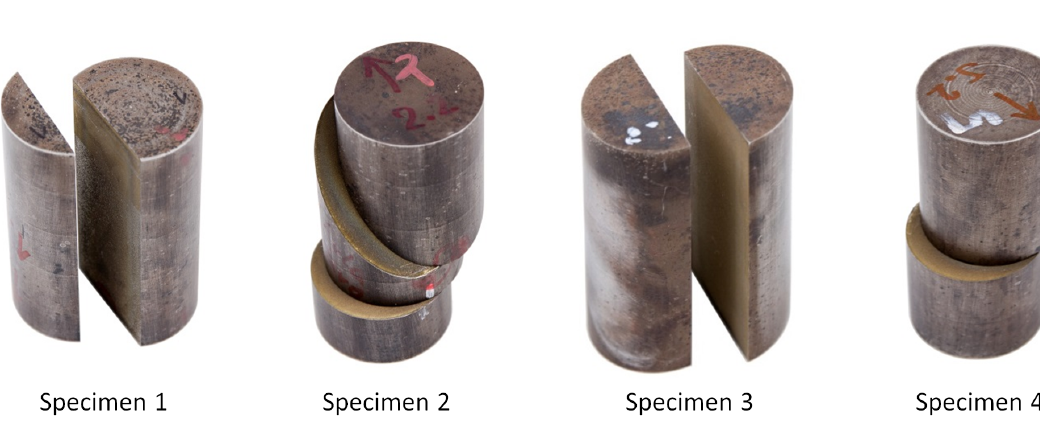
Figure 5. Cut-up specimens.